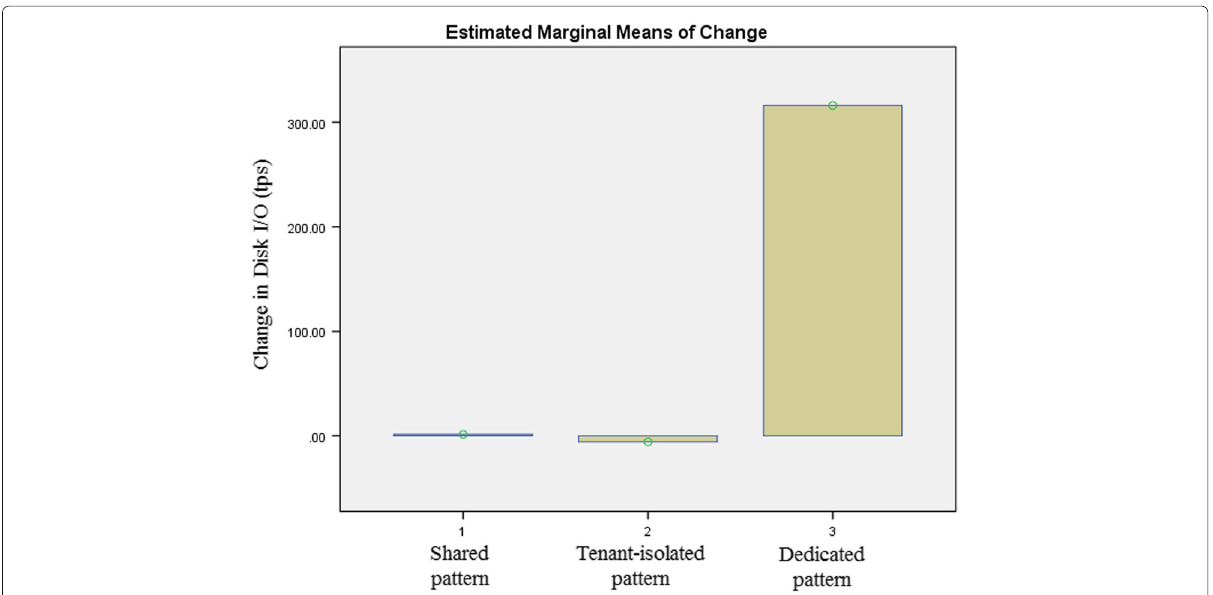
Fig. 27 Changes in Disk I/O [CS3]